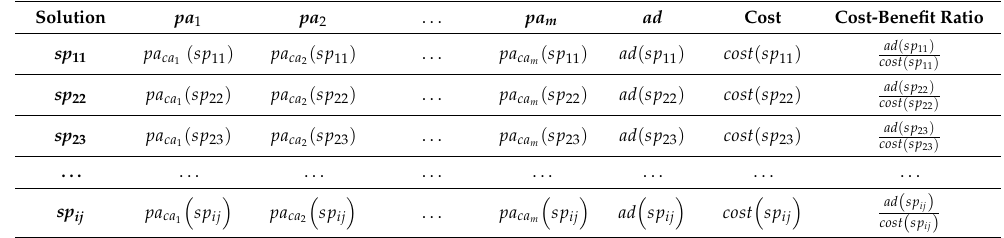
Table 9. Solution’s matrix